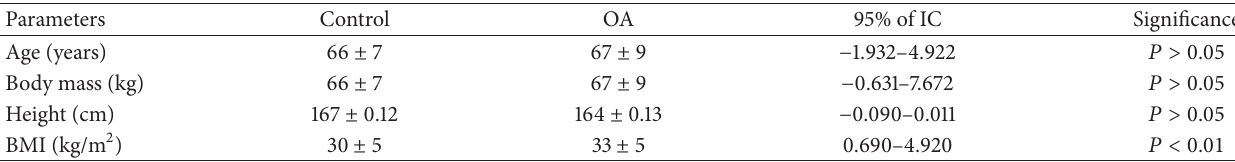
Table 2: Anthropometric